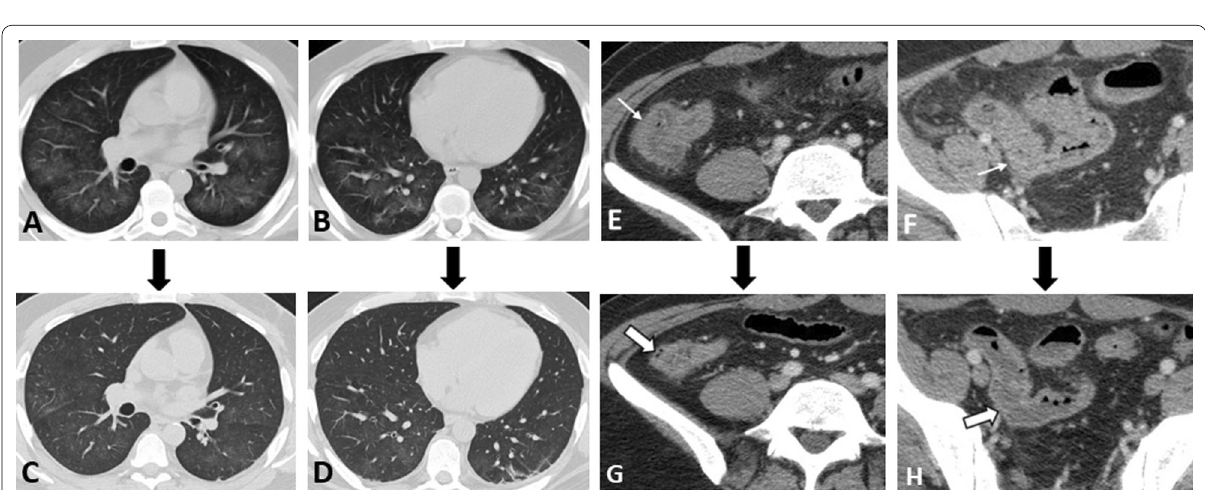
Fig. 8 Intestinal vasculitis and pulmonary alveolar hemorrhage in a 41-year-old male with ANCA-positive granulomatosis with polyangiitis (GPA) presenting with abdominal pain and hemoptysis. Axial thoracic CT images ( A , B ) at two different levels show diffuse mosaic attenuation secondary to geographic areas of ground-glass opacity, suggestive for alveolar hemorrhage. Follow-up CT images ( C , D ) three days after corticosteroid therapy demonstrate a notable response to treatment. CTE was also done with suboptimal small bowel distention ( E , F ) at admission to assess the cause of abdominal pain that revealed circumferential mural thickening at ascending colon and distal ileum (thin white arrows) associated with adjacent mesenteric fat haziness. Follow-up CT images ( G , H ) show complete response to corticosteroid therapy with normal bowel wall thickness (thick white arrows) and a decrease in attenuation of the ileocolic mesenteric